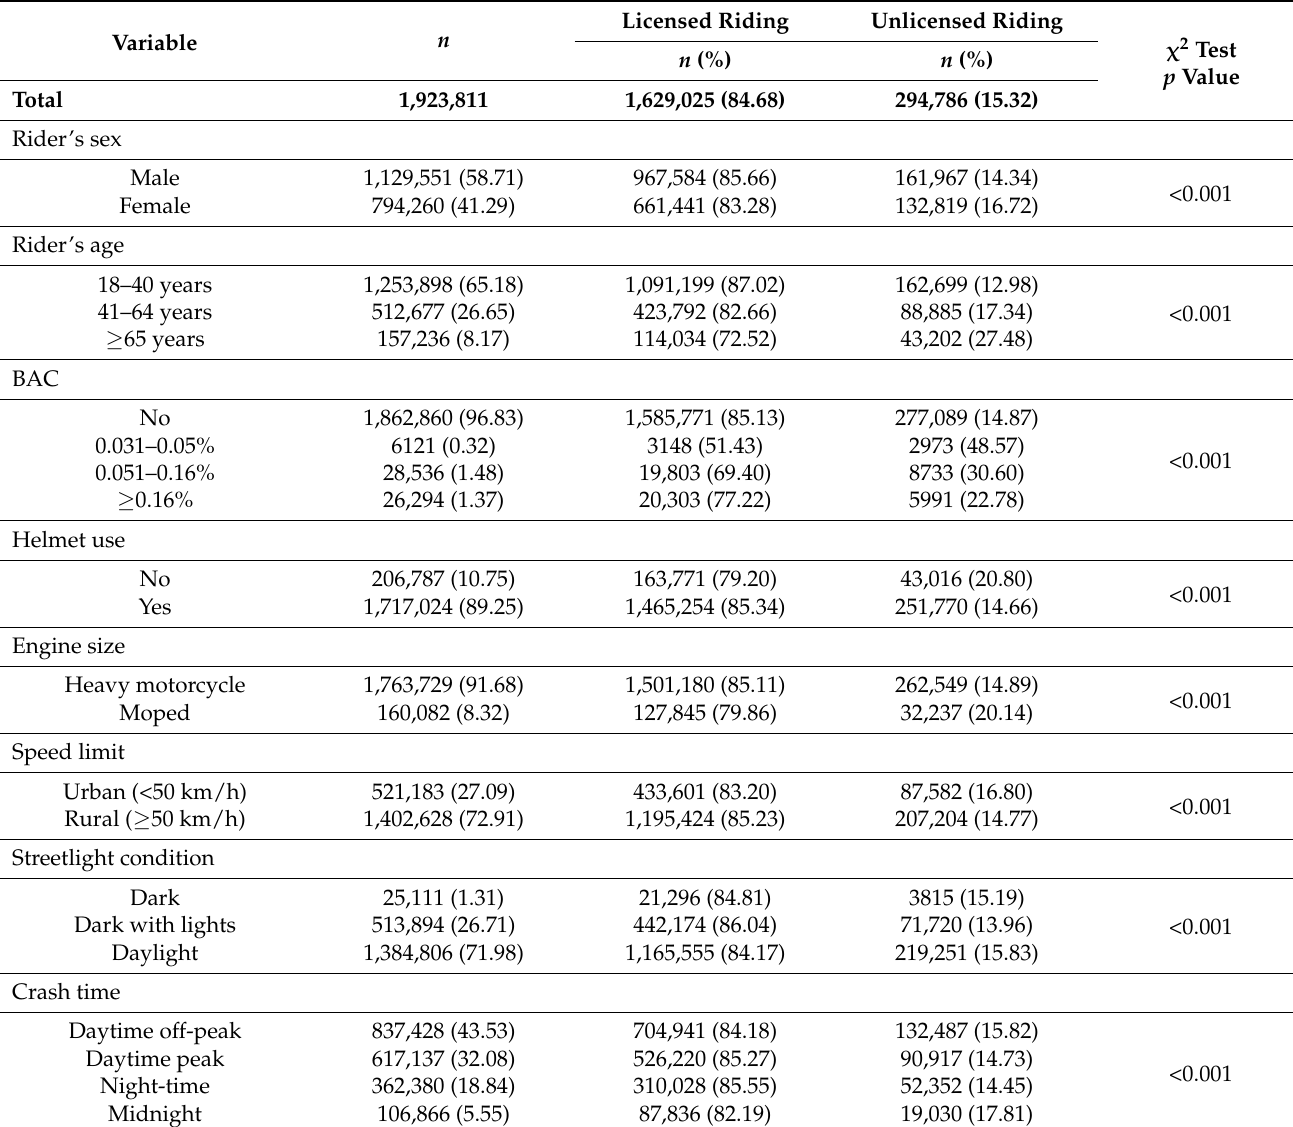
Table 2. Distribution of unlicensed